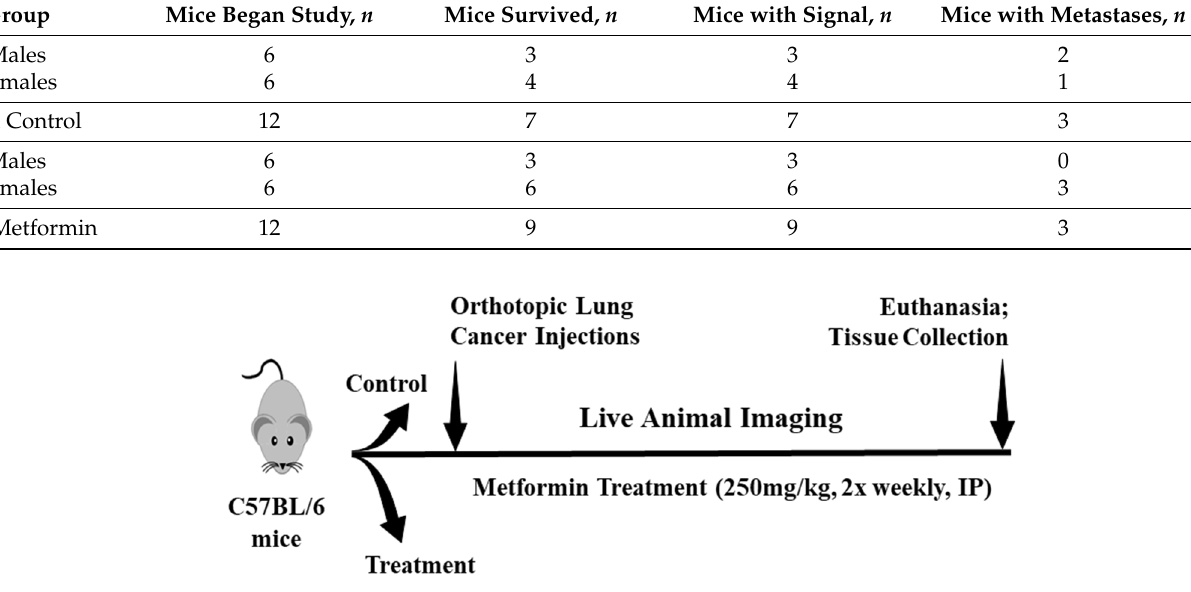
Table 1. C57Bl/6J mice survival and metastases following injection with LL/2 cells. Group